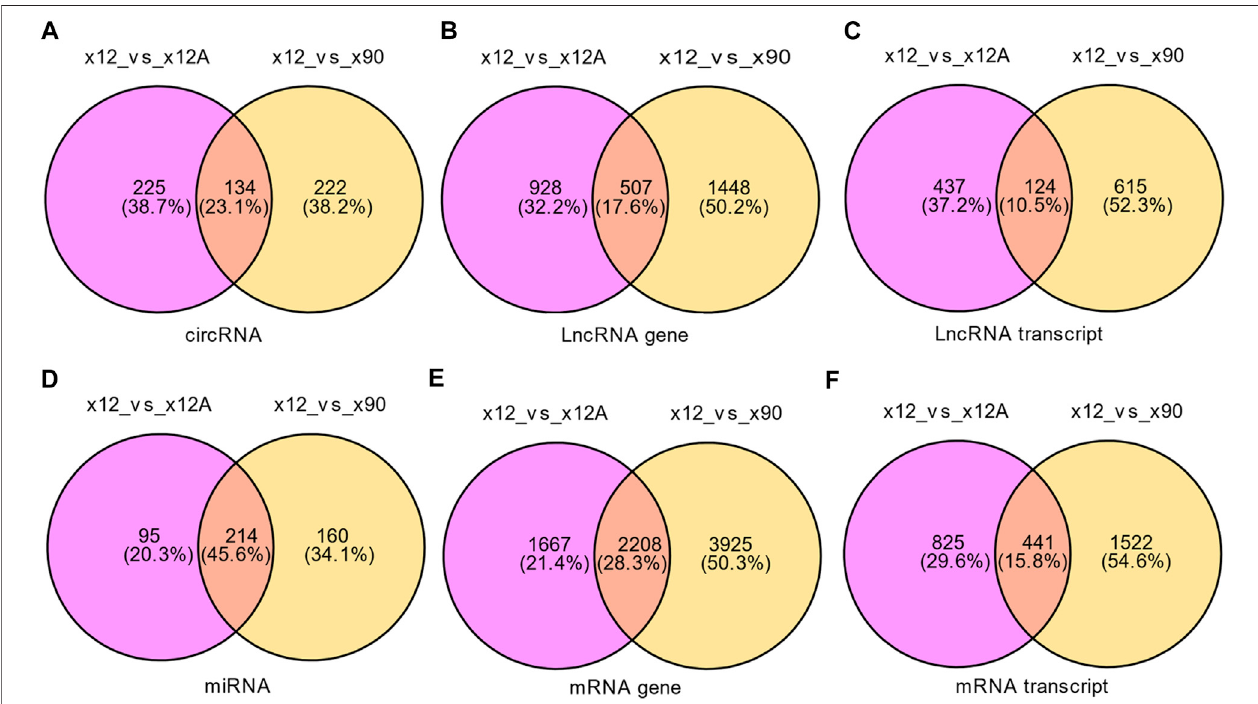
FIGURE5| VenndiagramofdifferentiallyexpressedRNAsinx12Aandx90astrocytes. (A) circRNA, (B) lncRNAgenelevel, (C) lncRNAtranscriptlevel, (D) miRNA, (E) mRNA gene level, and (F) mRNA transcript level in astrocytes treated with A β 42 oligomers and cultured for 90 days in vitro. The data were based on the prede fi ned thresholds (padj < 0.05, |log2FC| >